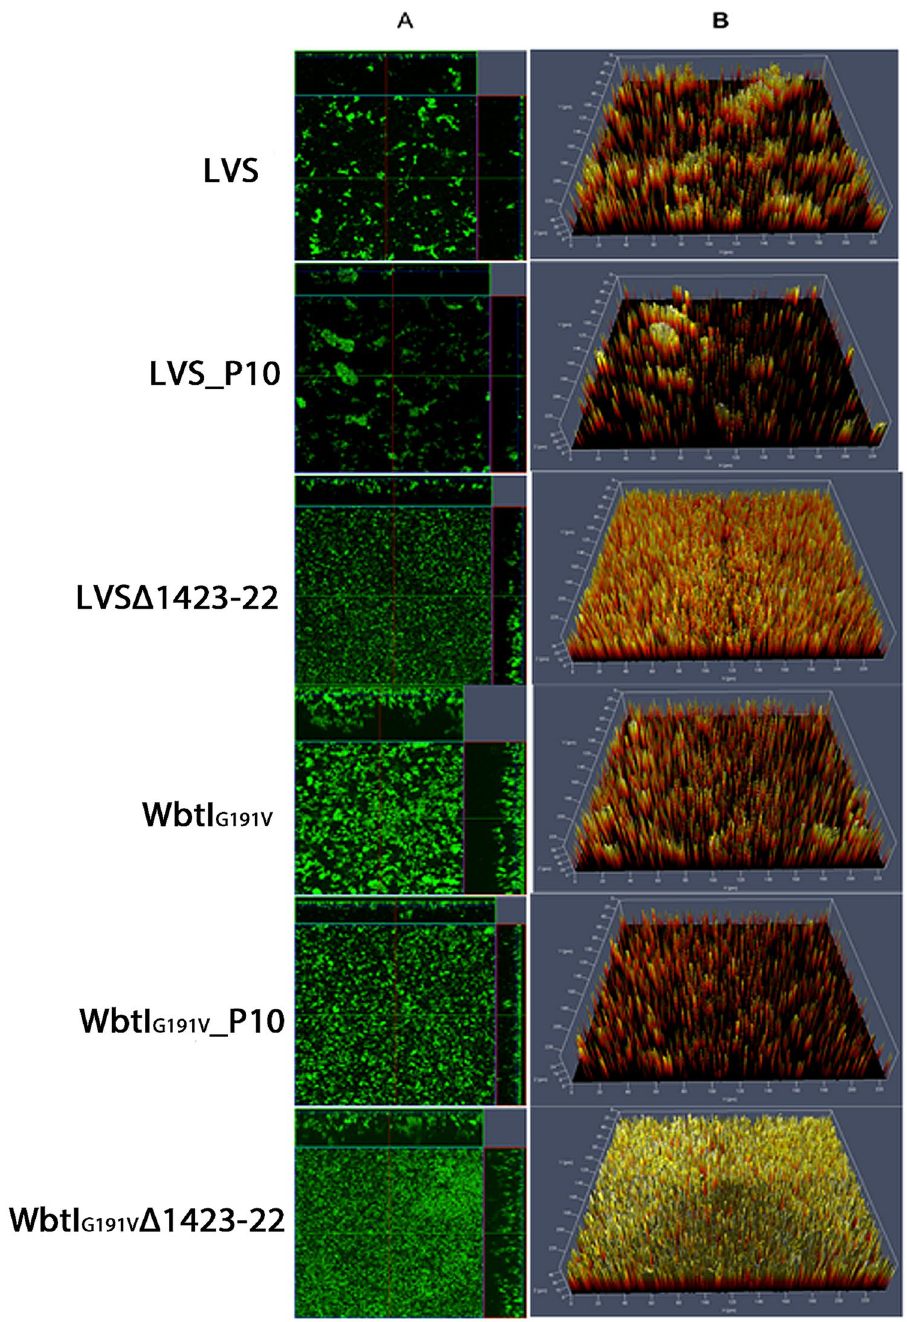
Figure 2. Comparison of biofilm formation by F . tularensis LVS, WbtI G191V (LPS O-Ag mutant), LVS Δ 1423- 22 (CLC mutant), and O-Ag and CLC double mutant before and after passage in CDMB by confocal laser scanning microscopy. Panel (A) contains orthogonal sections showing horizontal (z) and side views (x and y) of reconstructed three-dimensional biofilm images at a magnification of 25x. Biofilms were stained with Syto9 showing both live and dead bacterial cells. Panel (B) shows topographical images of biofilm growth of the parent LVS and its surface structure mutant strains. Loss of surface carbohydrate was associated with denser biofilms, but subculture passage in CDMB resulted in thinner